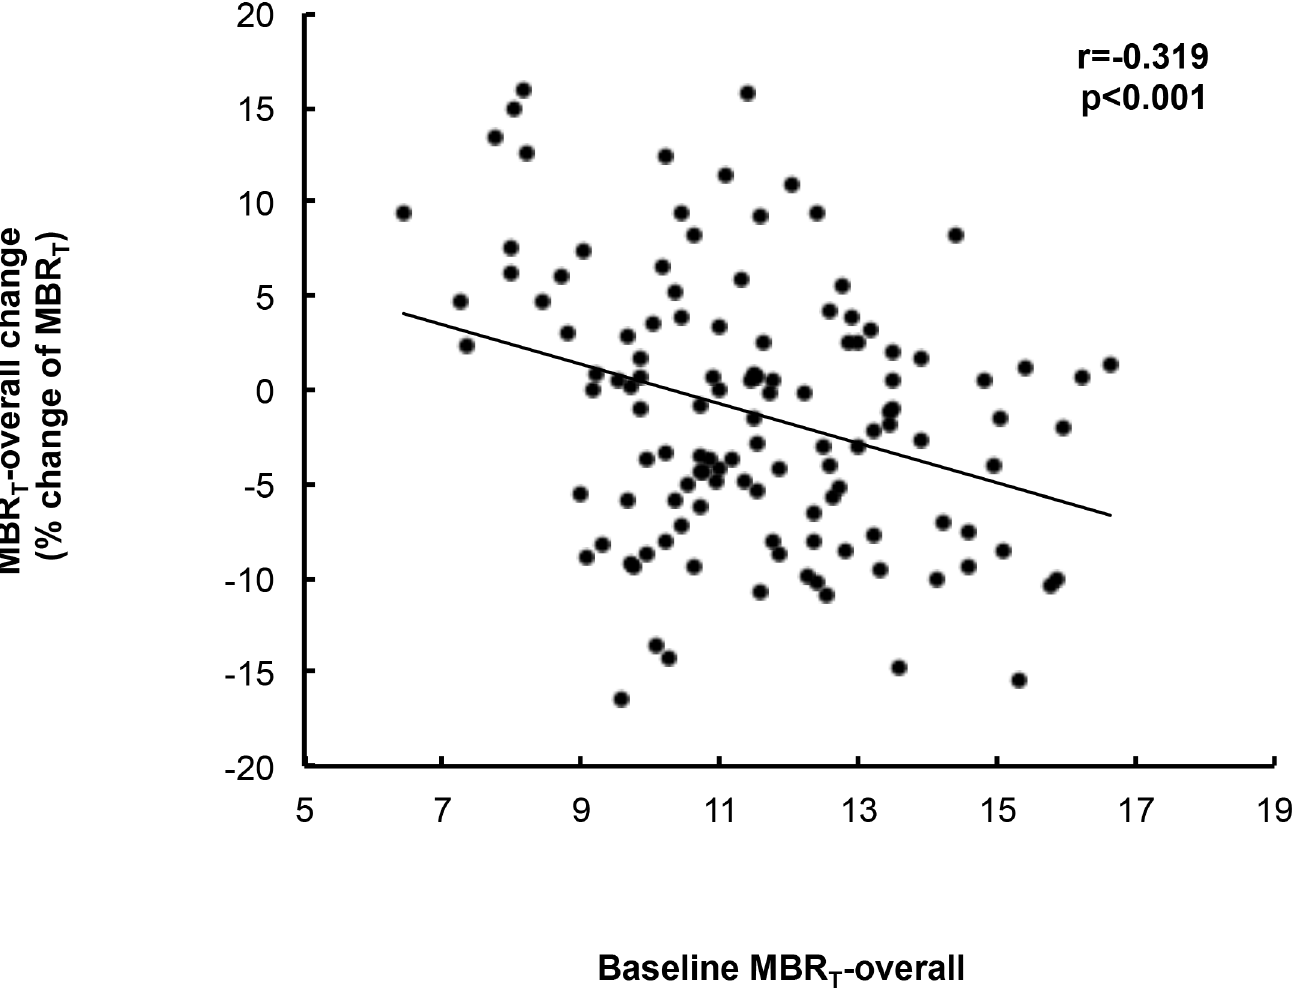
Fig 3. Relationship between baseline ocular blood flow and change of ocular blood flow after topical prostaglandin analogue administration in preperimetric glaucoma eyes.